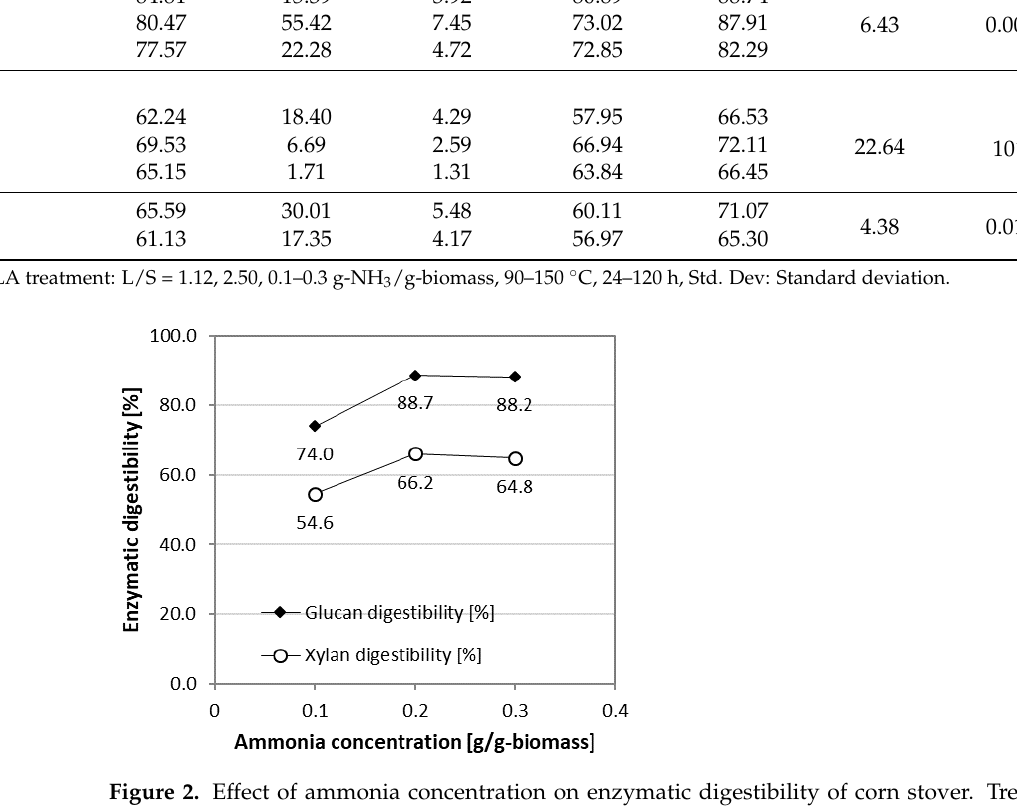
Figure 3. Effect of lignin content on enzymatic digestibility of corn stover. Treatment conditions: ( a ) ELLA treatment: L/S = 1.12, 0.3 g-NH 3 /g-biomass, 150 °C, 24 – 120 h; and ( b ) ELLA treatment: L/S = 2.5, 0.3 g-NH 3 /g-biomass, 150 °C, 24 – 120 h. ASL: acid soluble lignin; AIL: acid insoluble lignin. Enzymatic hydrolysis conditions: CTech2; 15 FPU/g-glucan loading; 50 °C, 150 rpm; hydrolysis time, 72 h.